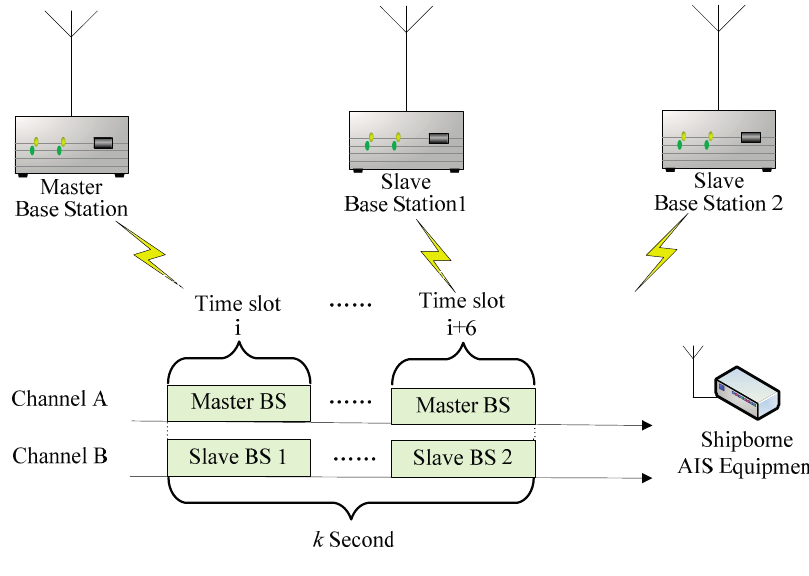
Figure 12. Experimental scheme of the verification system of